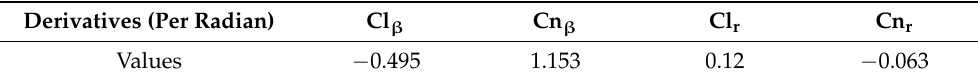
Table 21. Lateral-directional stability derivatives.